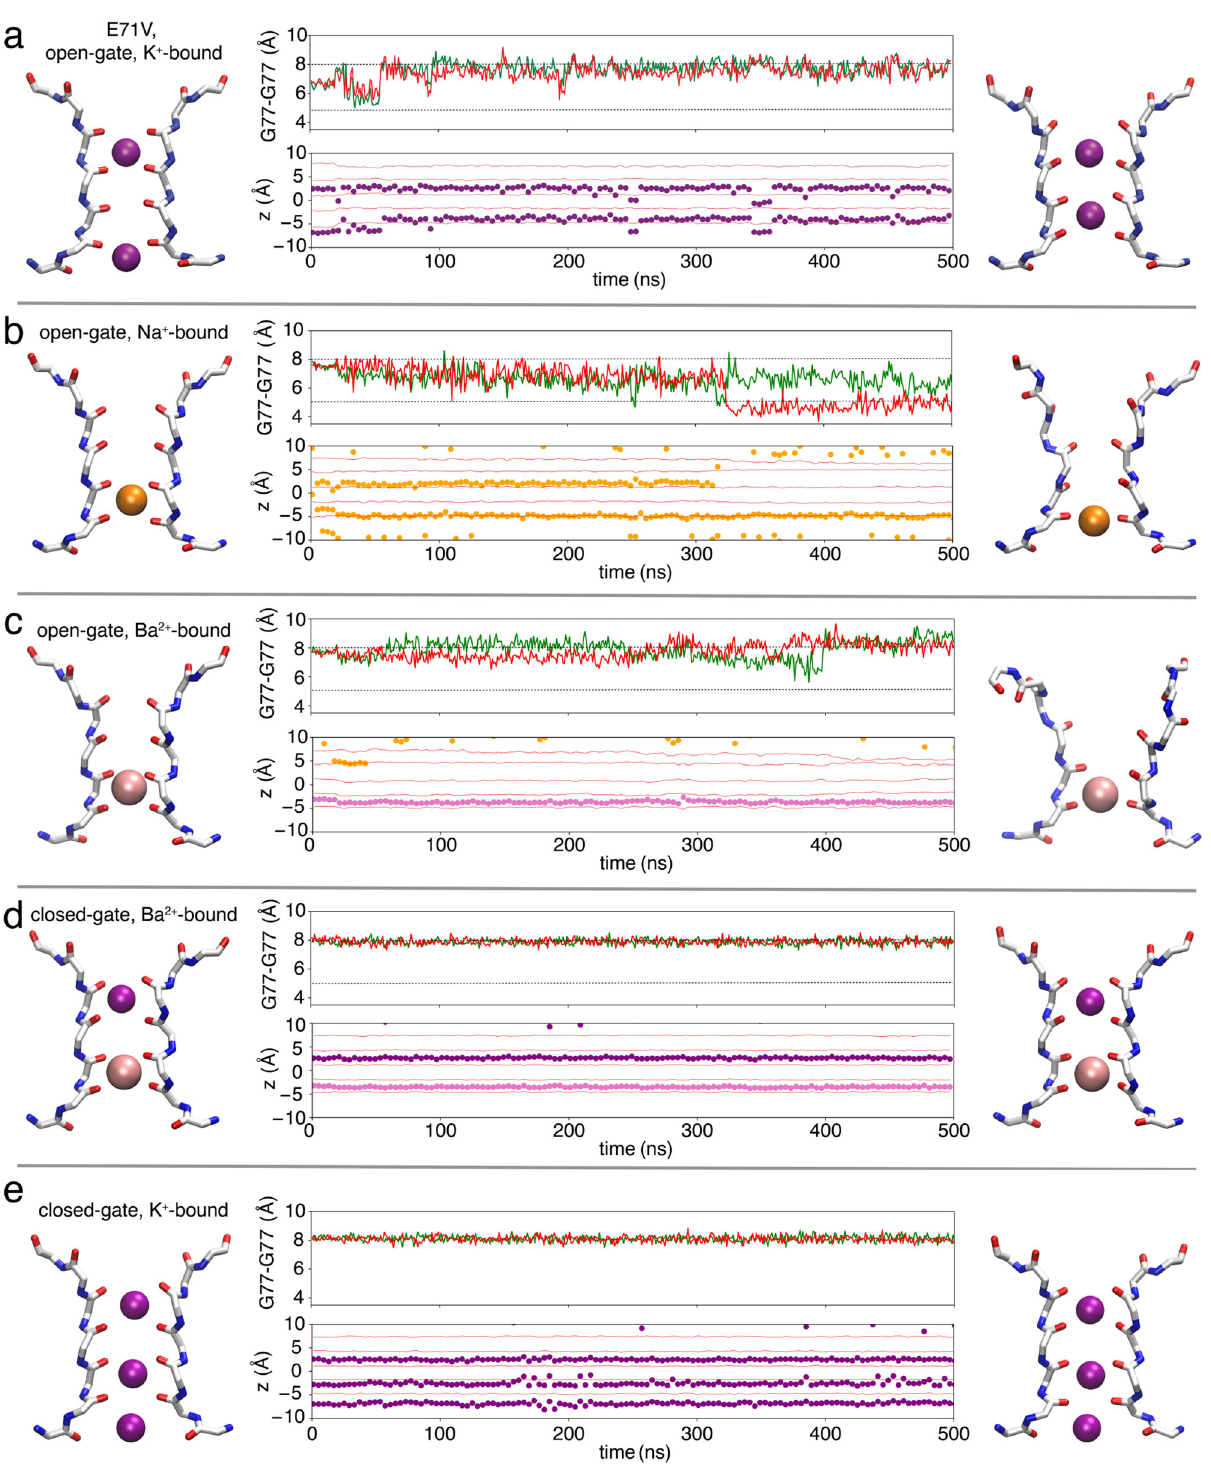
Fig. 7 MD simulations for the structures of the KcsA E71V mutant in different conditions. a Open-gate and K + bound, b open-gate and Na + bound, c open-gate and Ba 2 + bound, d closed-gate and Ba 2 + bound, and e closed-gate and K + bound. The fi rst and last snapshots of the selectivity fi lter for each MD trajectory are respectively shown (right and left panel) in licorice representation for backbone and in van der Waals representations for K + (purple), Na + (orange), and Ba 2 + (pink) ions. In the middle panel is the time series of the cross-subunit distance (r) between the C α atoms of G77 of diagonally opposed monomers A and C (green), and B and D (red). Two levels representing conductive and constricted states are illustrated in black dashed line. The z-coordinate of ions in the selectivity fi lter are shown as solid dots (with the same colors as the conformation images). The z-coordinates of carbonyl oxygens of G79, Y78, G77, V76, and T75 are respectively shown in red lines to indicate the position of ion binding